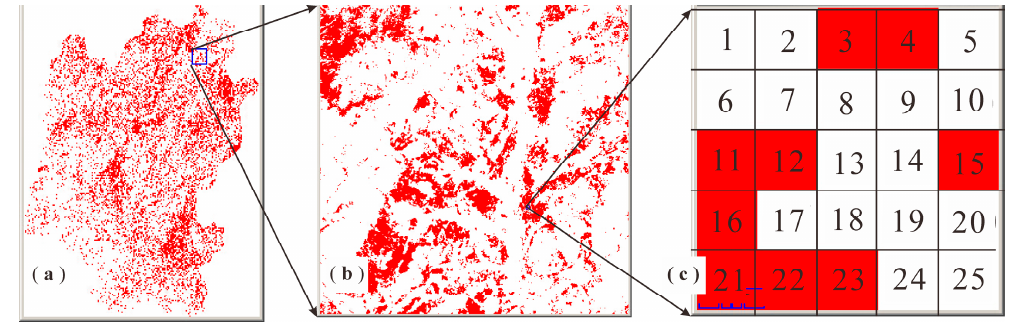
Figure 6. ( a ) The results of the determination of table instances; ( b ) the results are amplified two times; and ( c ) the results are amplified 40 times.